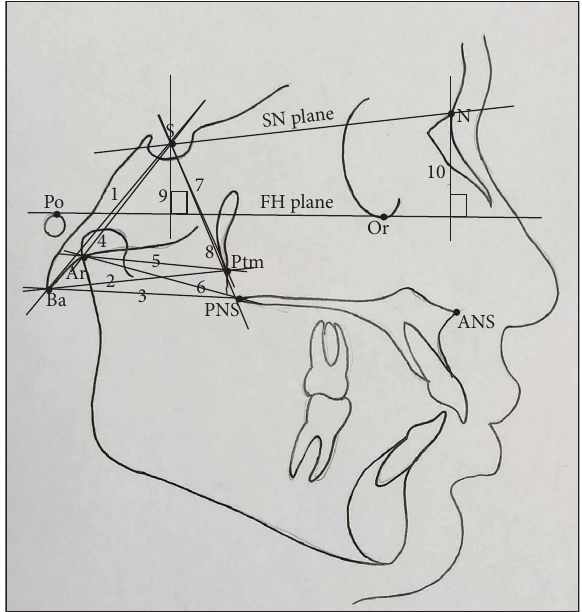
Figure 2: Linear parameters. (1) S-Ba, the linear distance between S and Ba; (2) Ba-Ptm, the linear distance between Ba and Ptm; (3) Ba- PNS, the linear distance between Ba and PNS; (4) S-Ar, the linear distance between S and Ar; (5) Ar-Ptm, the linear distance between Ar and Ptm; (6) Ar-PNS, the linear distance between Ar and PNS; (7) S-Ptm, the linear distance between S and Ptm; (8) S-PNS, the linear distance between S and PNS; (9) S-FH, the linear perpen- dicular distance from S to FH plane, (10) N-FH, the linear per- pendicular distance from N to FH plane. S-FH: N-FH, the ratio of S-FH and N-FH distances in %.